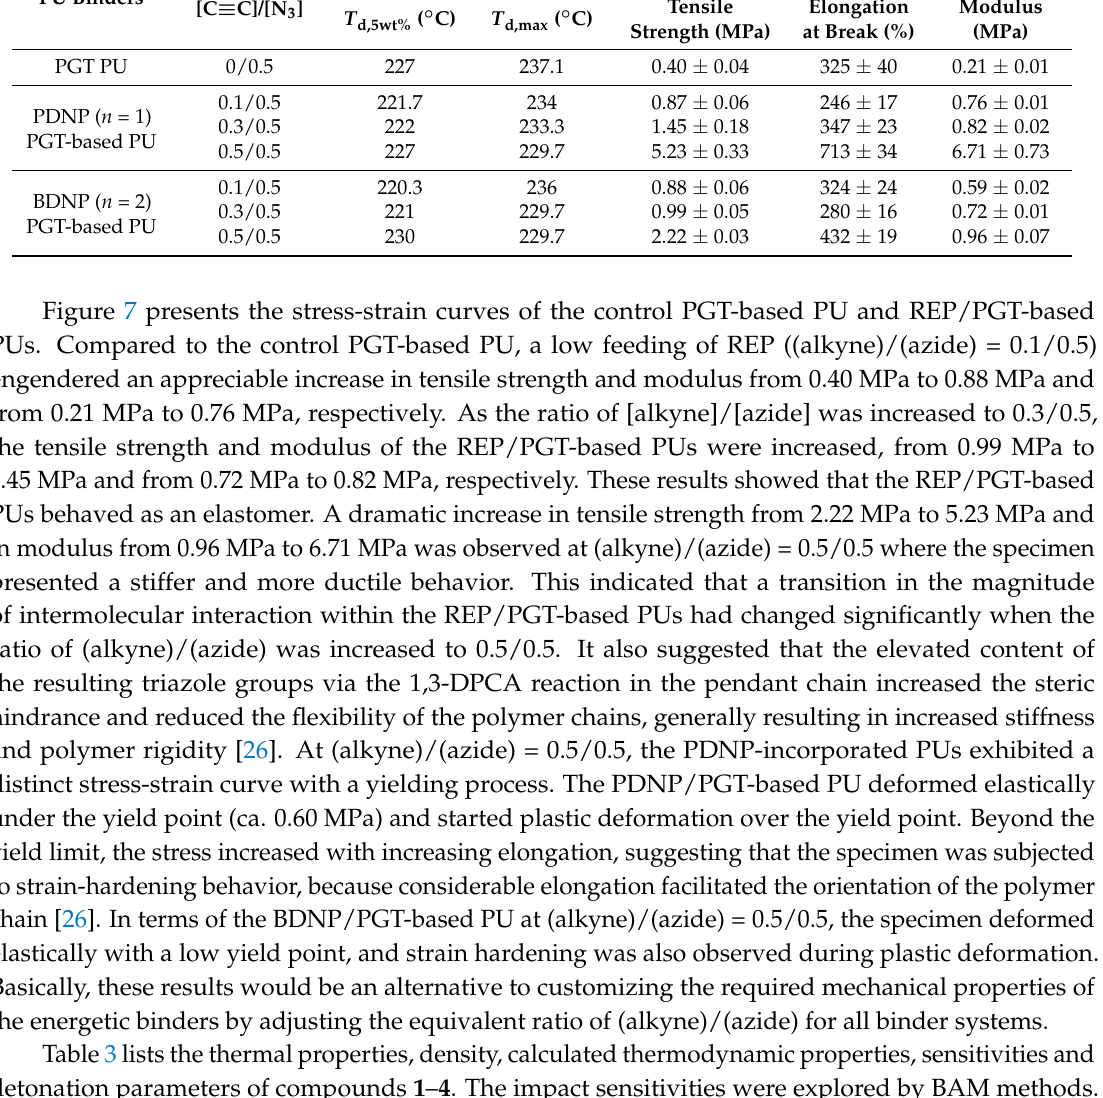
Table 2. Summary of thermal stabilities and mechanical properties of REP/PGT-based PUs. TGA in N 2 Mechanical Properties Mole Ratio of PU Binders [C ≡ C]/[N 3 ] T d,5wt% ( ◦